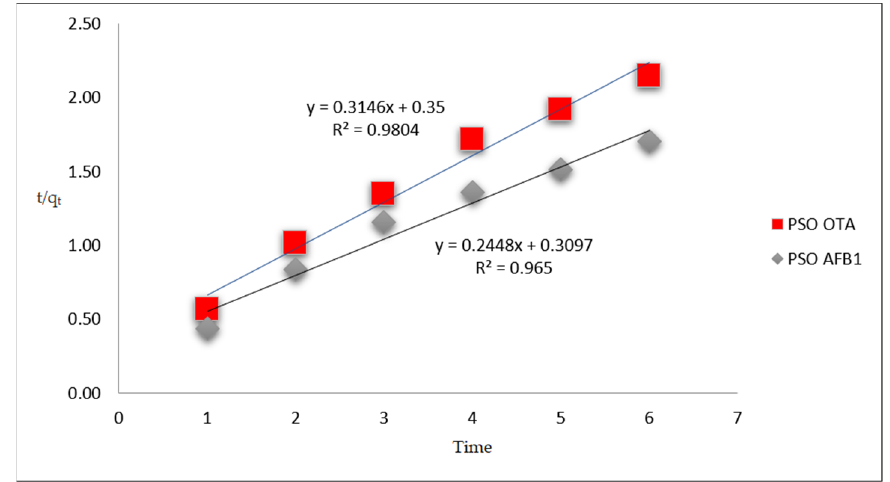
Figure 5. Pseudo-second-order kinetics for adsorption of AFB1 and OTA with MGO.